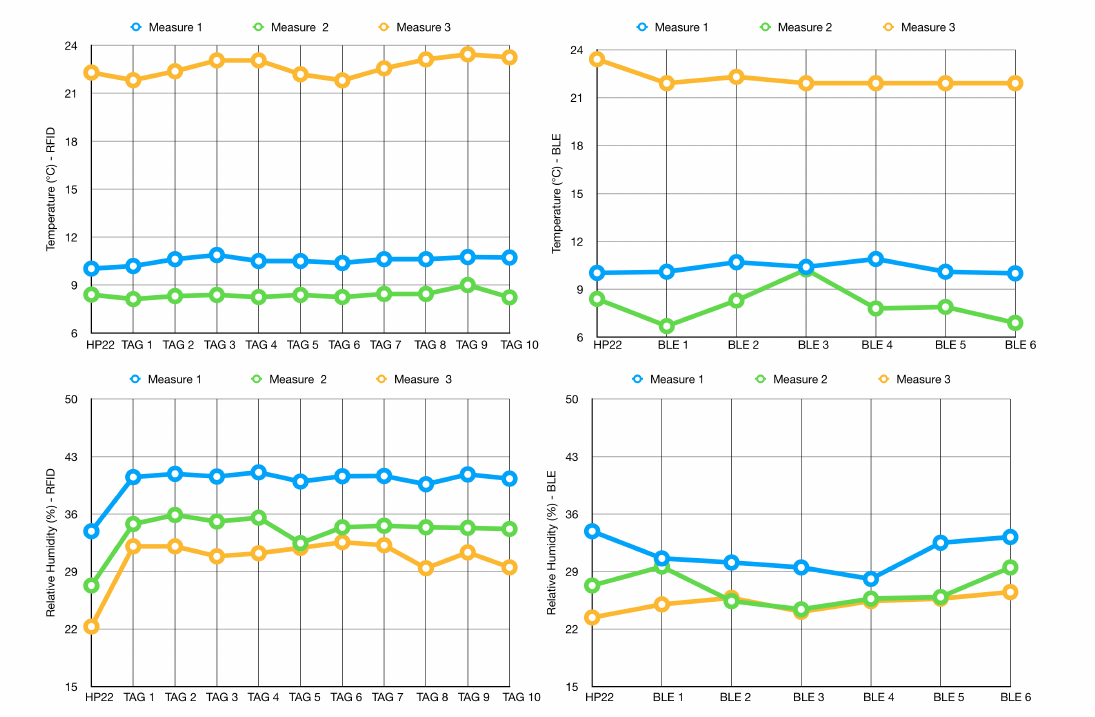
Figure 12. Point to point calibration